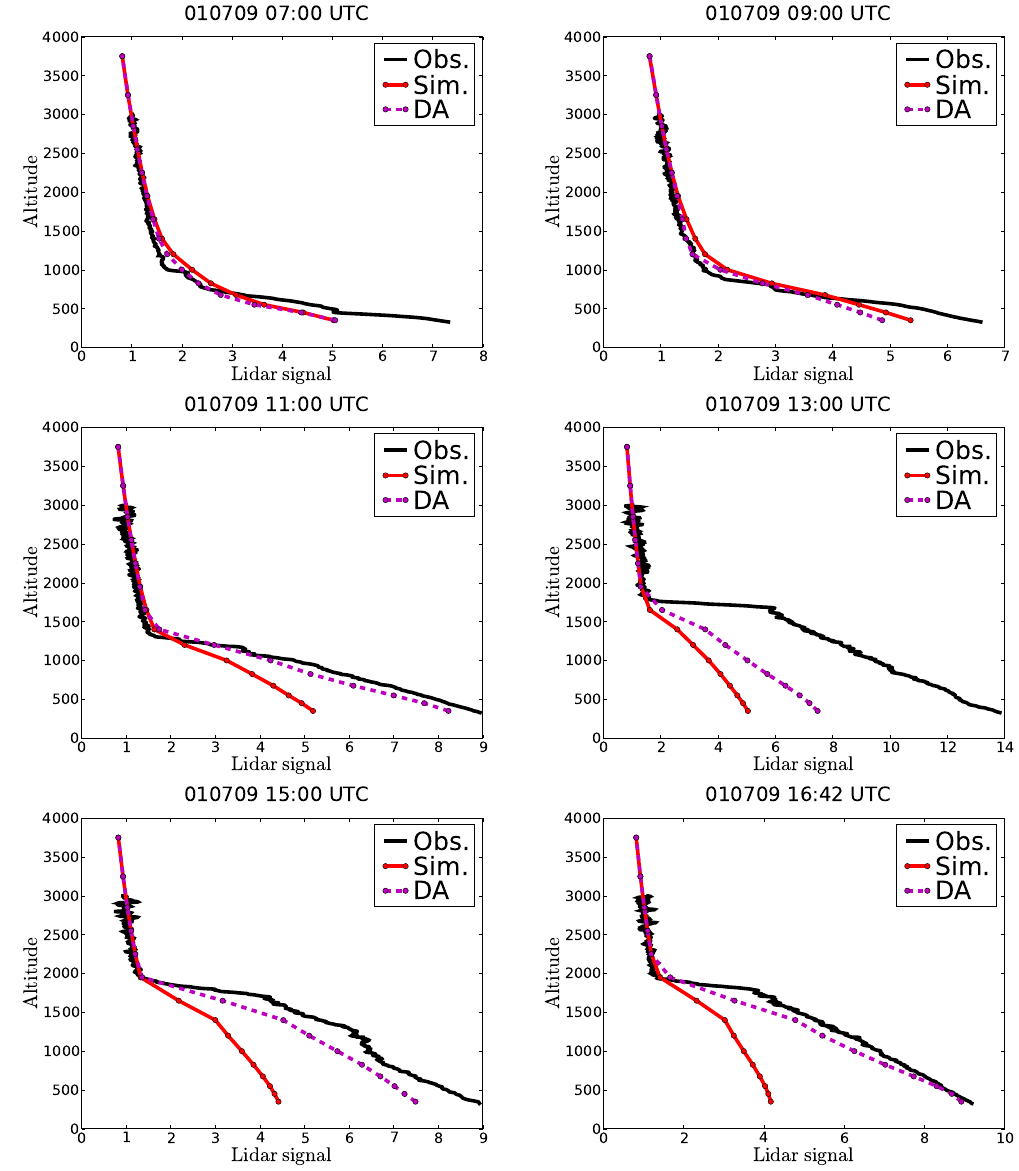
Fig. 11. Lidar vertical profiles observed by the ground-based in situ lidar at Saclay (black lines), simulated without DA (red lines) and simulated with DA (magenta lines) on 01 July 2009.